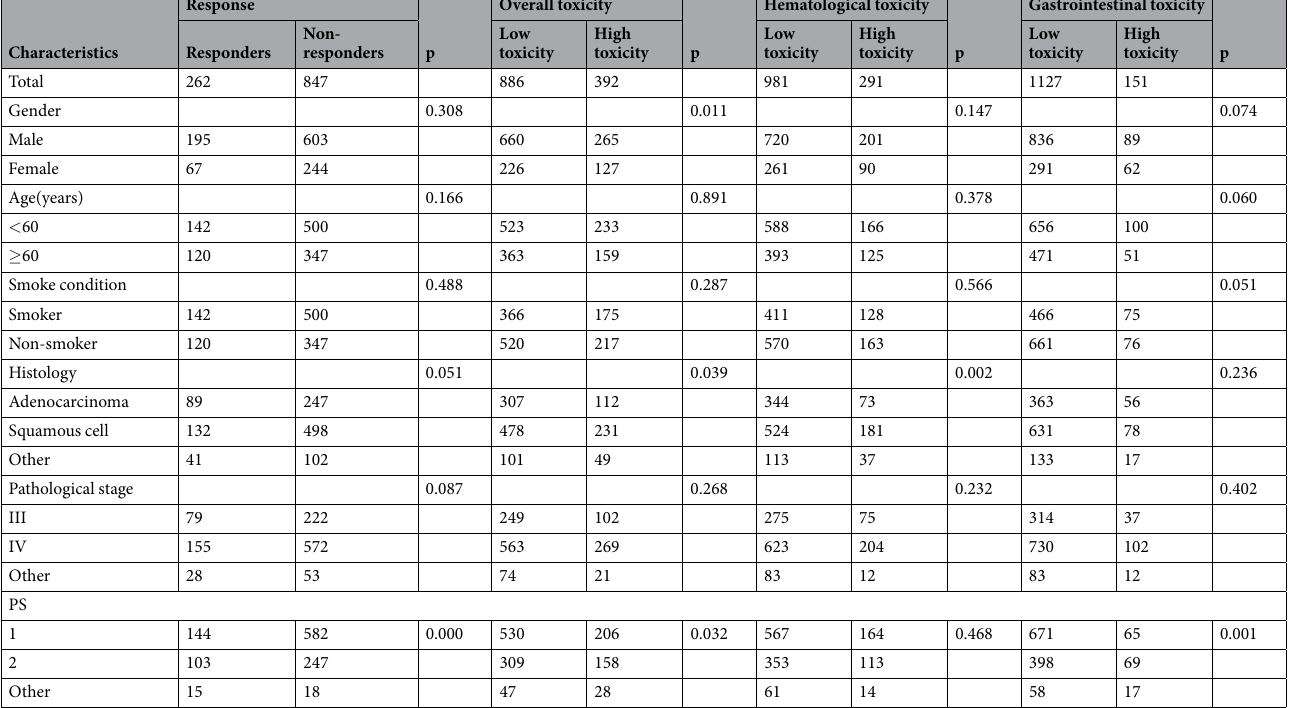
Table 1. Characteristics of all patients enrolled in this